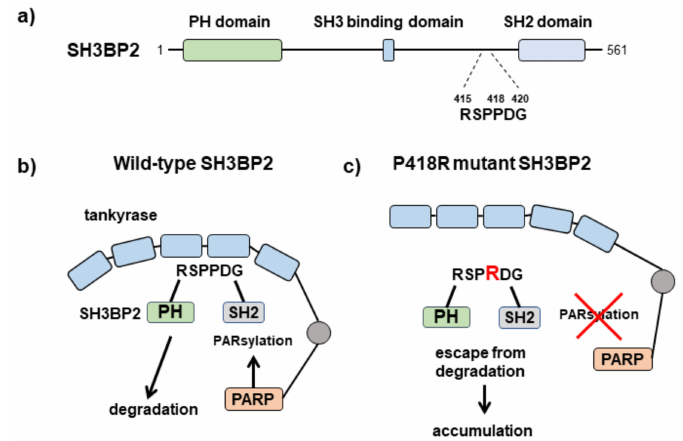
Figure 3. Structure of SH3 domain-binding protein 2 (SH3BP2) and increased SH3BP2 accumulation in SH3BP2 cherubism mutant cells. ( a ) Structure of SH3BP2. SH3BP2 protein consists of three